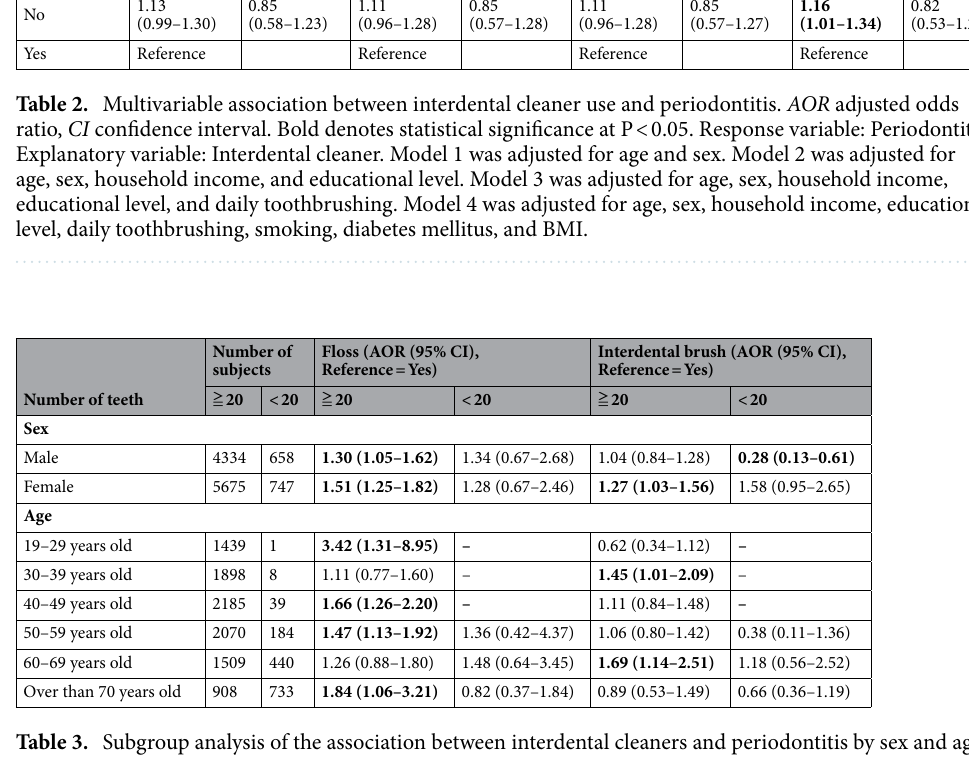
Table 3. Subgroup analysis of the association between interdental cleaners and periodontitis by sex and age. AOR adjusted odds ratio, CI confidence interval. Bold denotes statistical significance at P < 0.05. –: Logistic regression analysis is not possible due to insufficient number of